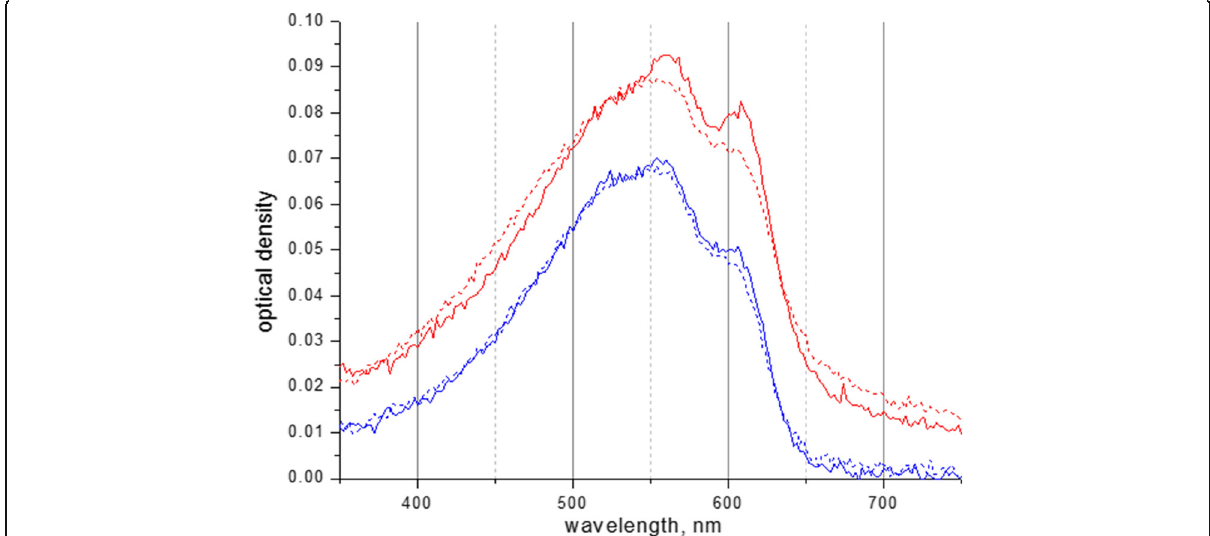
Fig. 10 Electronic absorption spectra of as-prepared samples ( solid curves ) and the same samples 2 weeks later ( dotted curves ) of P3HT-PMMA (1:50 weight ratio, red lines ) and P3HT-PMMA (1:4 weight ratio, blue lines